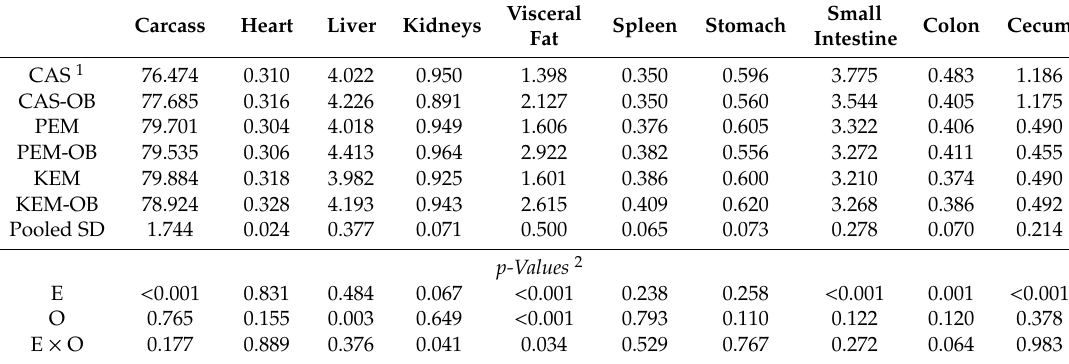
Table 4. Organs relative weight (g / 100 g fresh body weight) of rats fed casein or casein plus extruded mix diets either obesogenic or